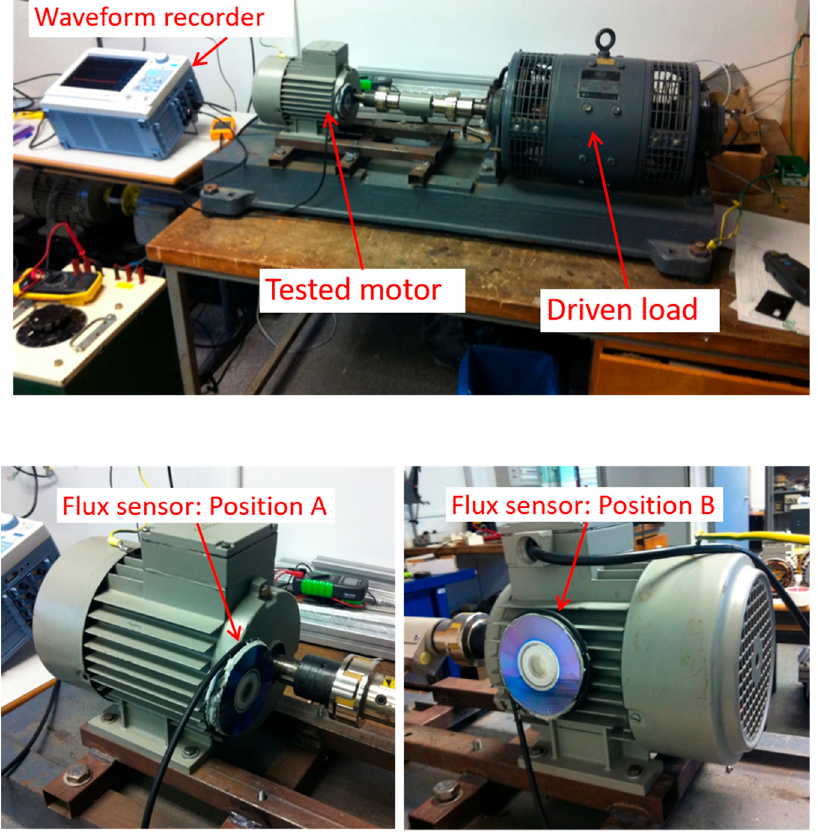
Figure 4. Experimental test bench and two considered positions of the flux sensor [28].